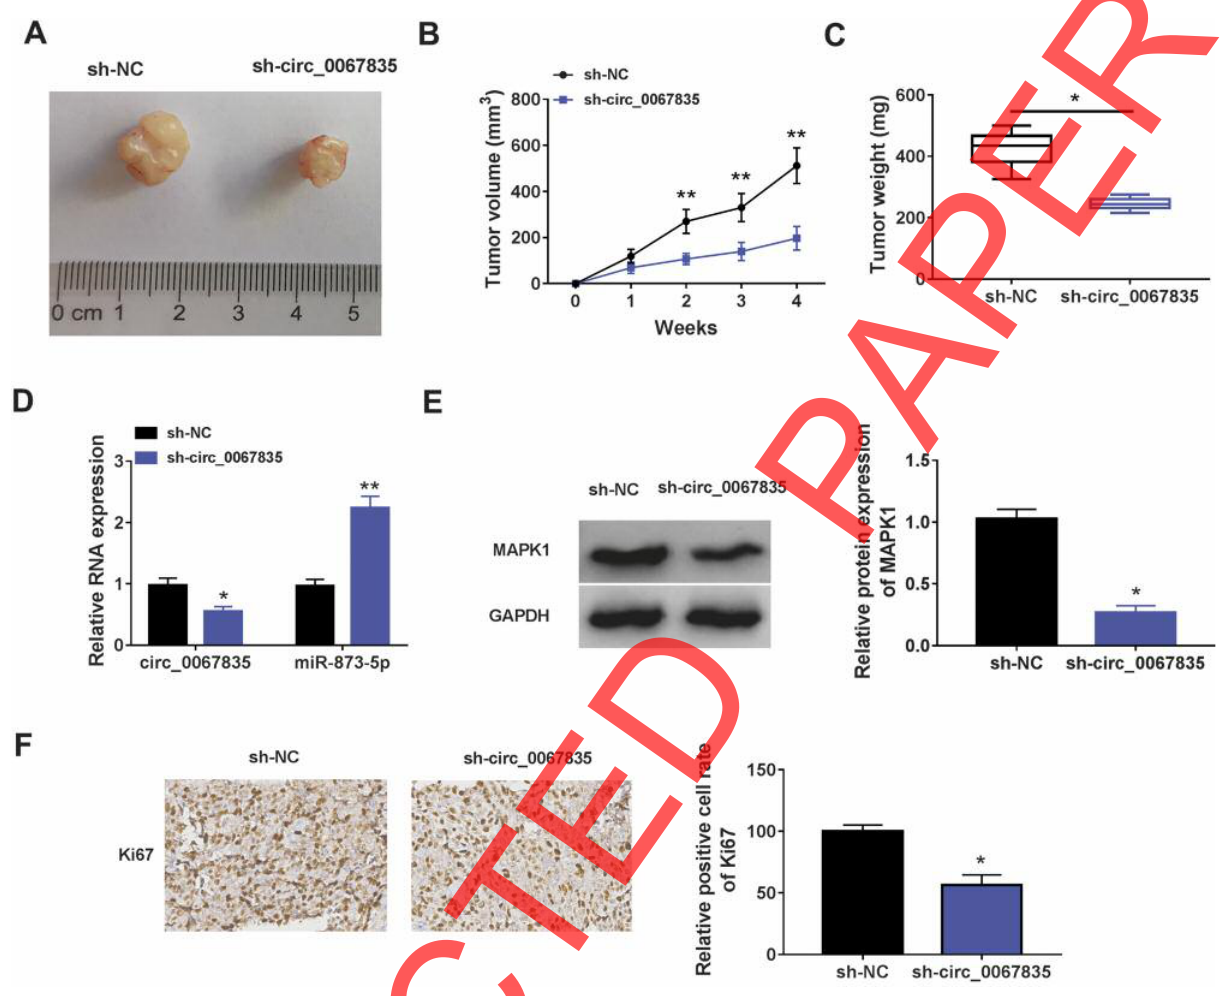
Fig. 8 Circ_0067835 knockdown repressed CRC tumor growth in vivo . HCT116 cells stably expressing sh-NC or sh-circ_0067835 were subcutaneously injected into BALB/c mice (n = 6). (A) Picture of generated tumors. (B) Volume of generated tumors measured once a week. (C) Weight of tumors measured at 4 weeks after injection. (D) qRT-PCR assay for the relative expression of circ_0067835 and miR-873-5p in generated tumors. (E) Western blot assay for the protein level of MAPK1 in generated tumors. (F) Immunohisto- chemistry assay showing the expression of Ki67 in tumors. * p < 0.05, ** p < 0.01.